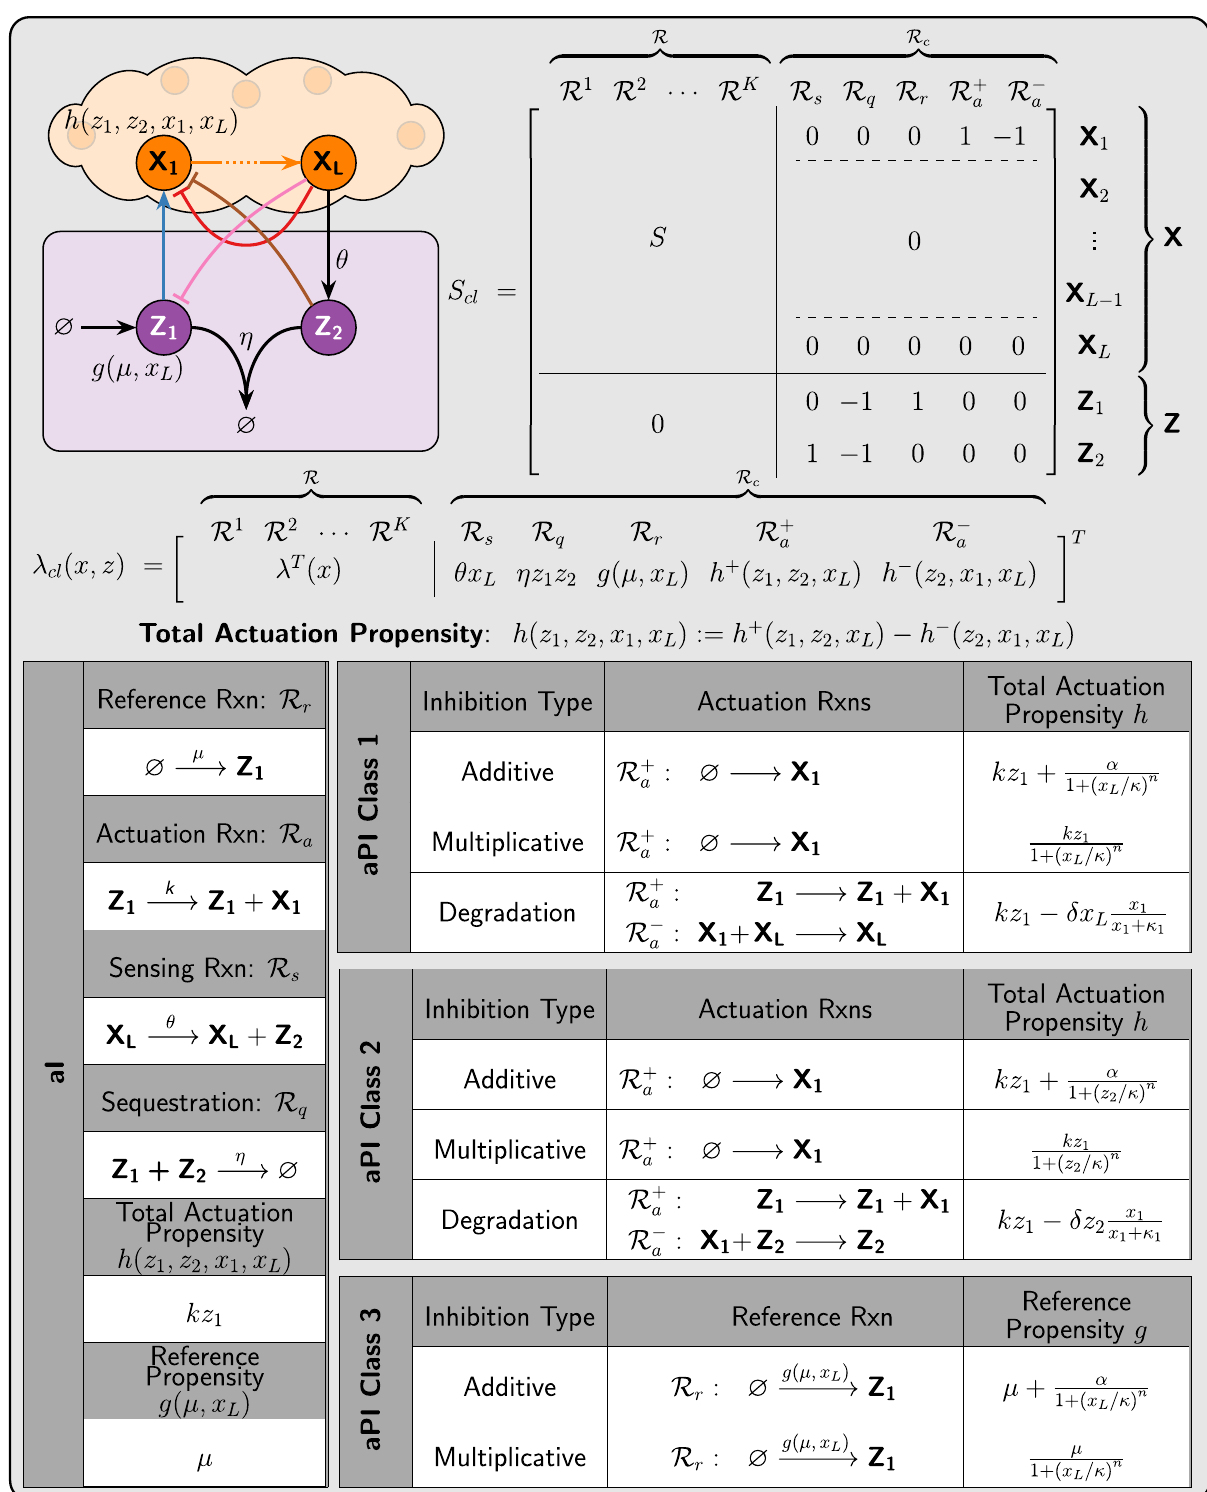
similar to the previous scenario where ρ < 1, and (3) another unstable region where sustained oscillations emerge as depicted in the bottom plot of Fig. 4c. Note that the closer ρ is to 2, the narrower the stable region is. Thirdly, for ρ > 2, the stable region disappears and thus this a PI controller has no hope of stabilizing the dynamics without re-tuning the parameters related to the standalone a I controller (e.g., k and/or θ ). Clearly, multiplicative